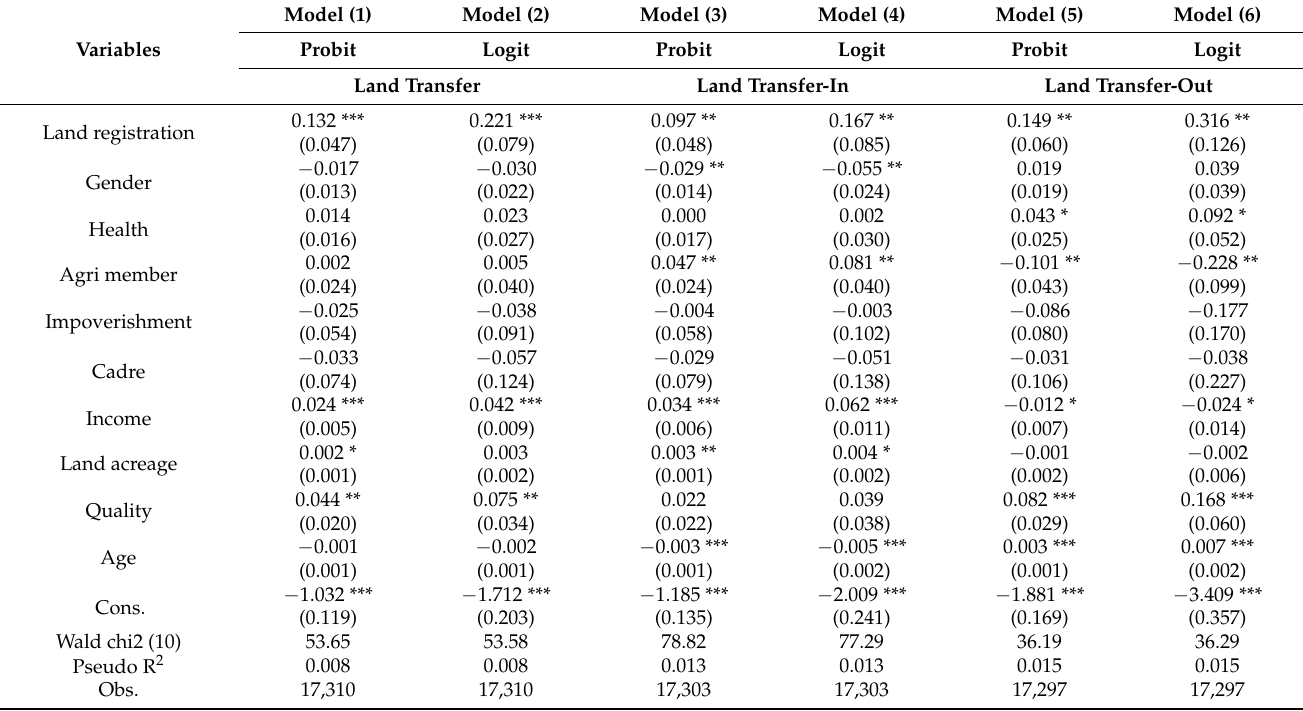
Table A1. Estimation results of Logit and Probit models of the impacts of the land registration program on land